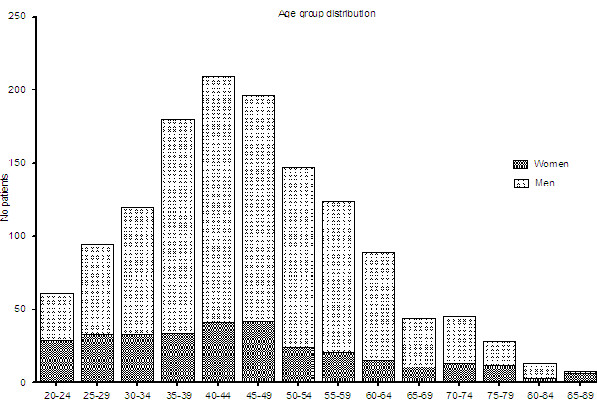
Age distribution of urolithiasis patients admitted to our emergency department.